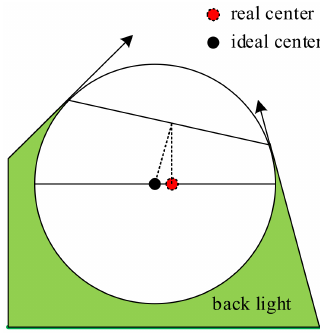
Figure 3. Light near the